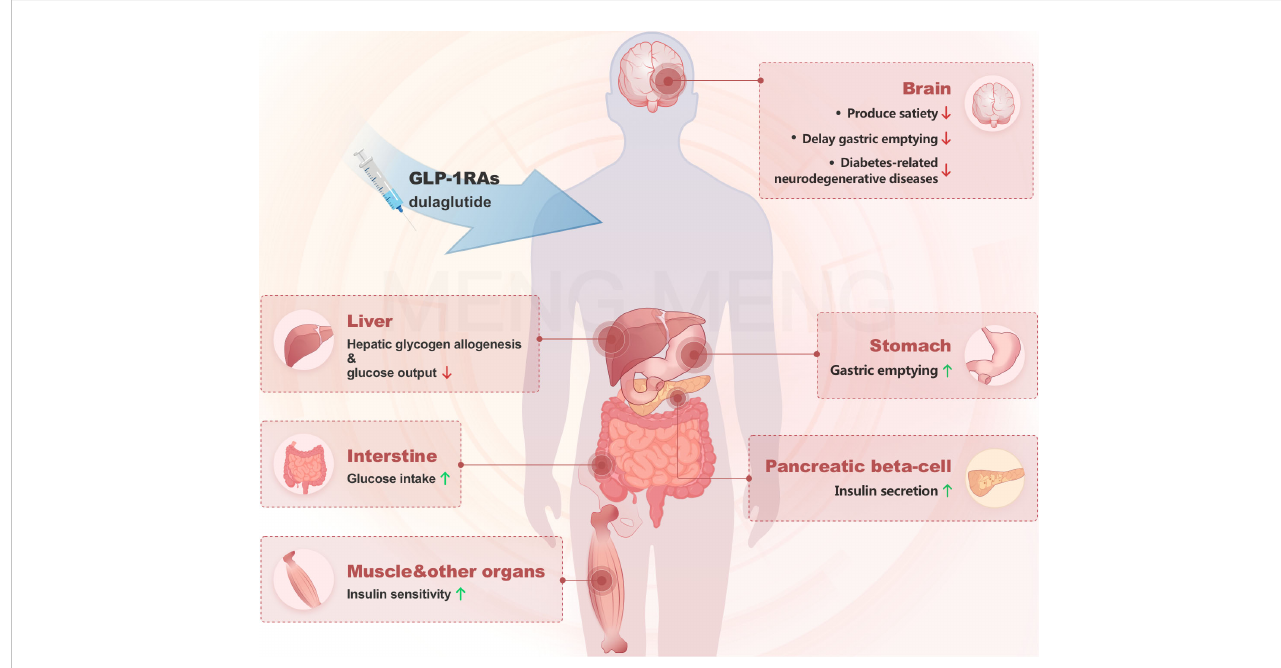
FIGURE 1 The mechanism of action of Dulaglutide in decreasing blood